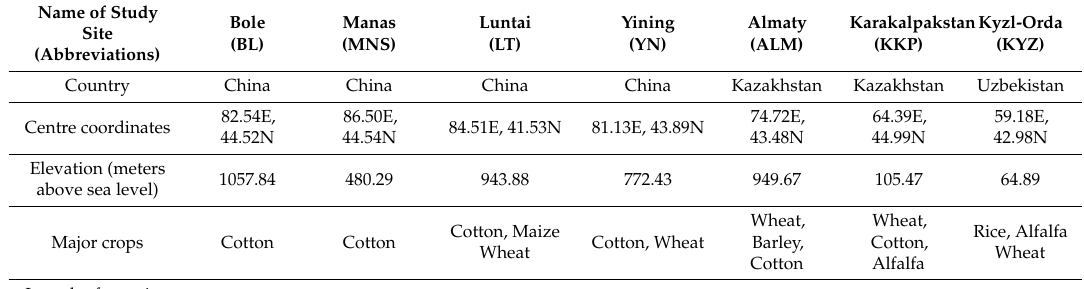
Table 1. Summary of the seven study areas in Xinjiang and the Aral Sea